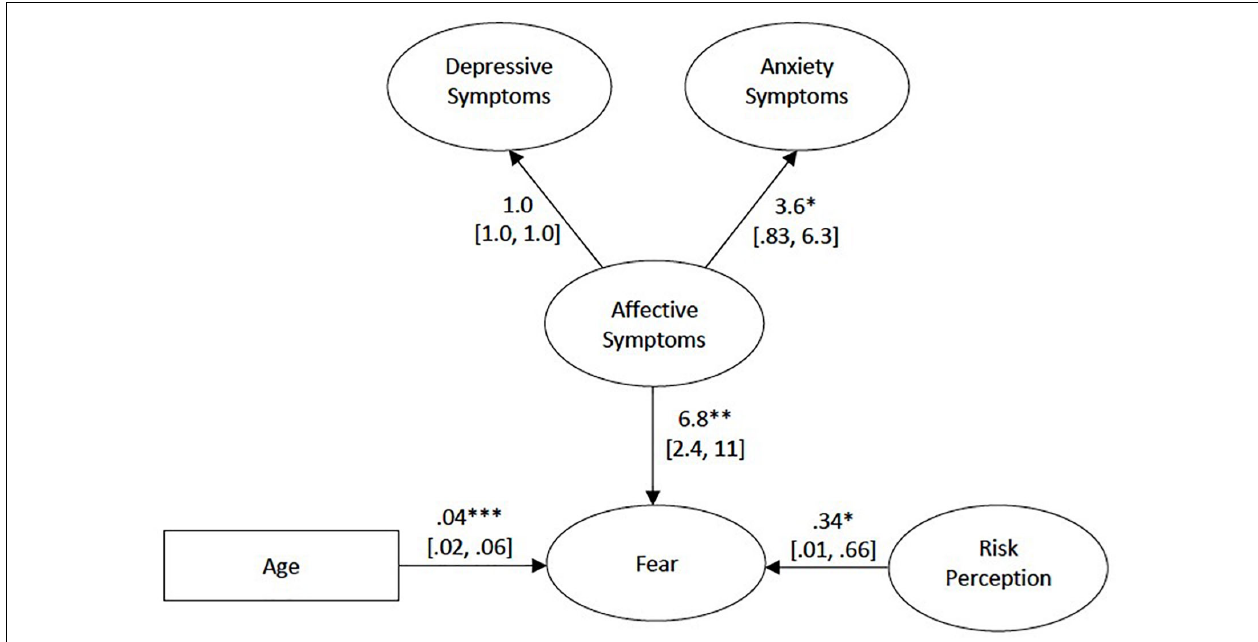
FIGURE 2 | Final model. Unstandardized regression estimates are shown. Ovals represent latent variables, while the rectangle represents the observed variable. Correlated errors among the items in the COVID-19 Fear Inventory are not shown for clarity. Statistical significance for the path between depressive and affective symptoms was not tested as it was set to 1. Figures in brackets represent the Confidence Intervals. * p < 0.05, ** p < 0.01, *** p < 0.001.